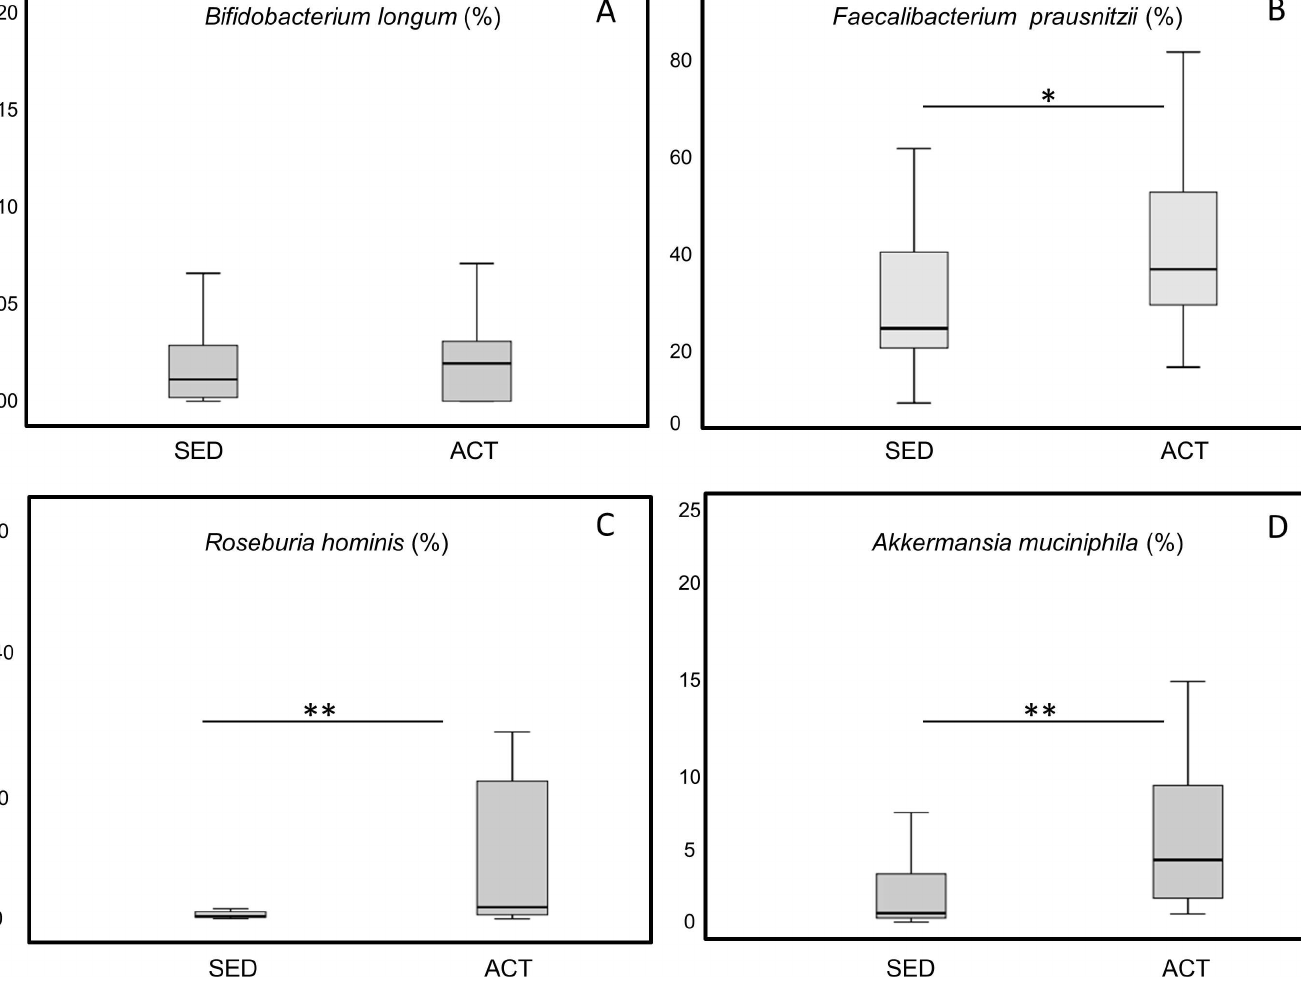
Fig 3. Changes induced in relative abundance of gut bacteria species by lifestyle in women. (A) Bifidobacterium longum , ( B) Faecalibacterium prausnitzii , (C) Roseburiahominis ,(D) Akkermansia muciniphila . Data were log transformed and analyzedby t-test * p < 0.05 ** p <